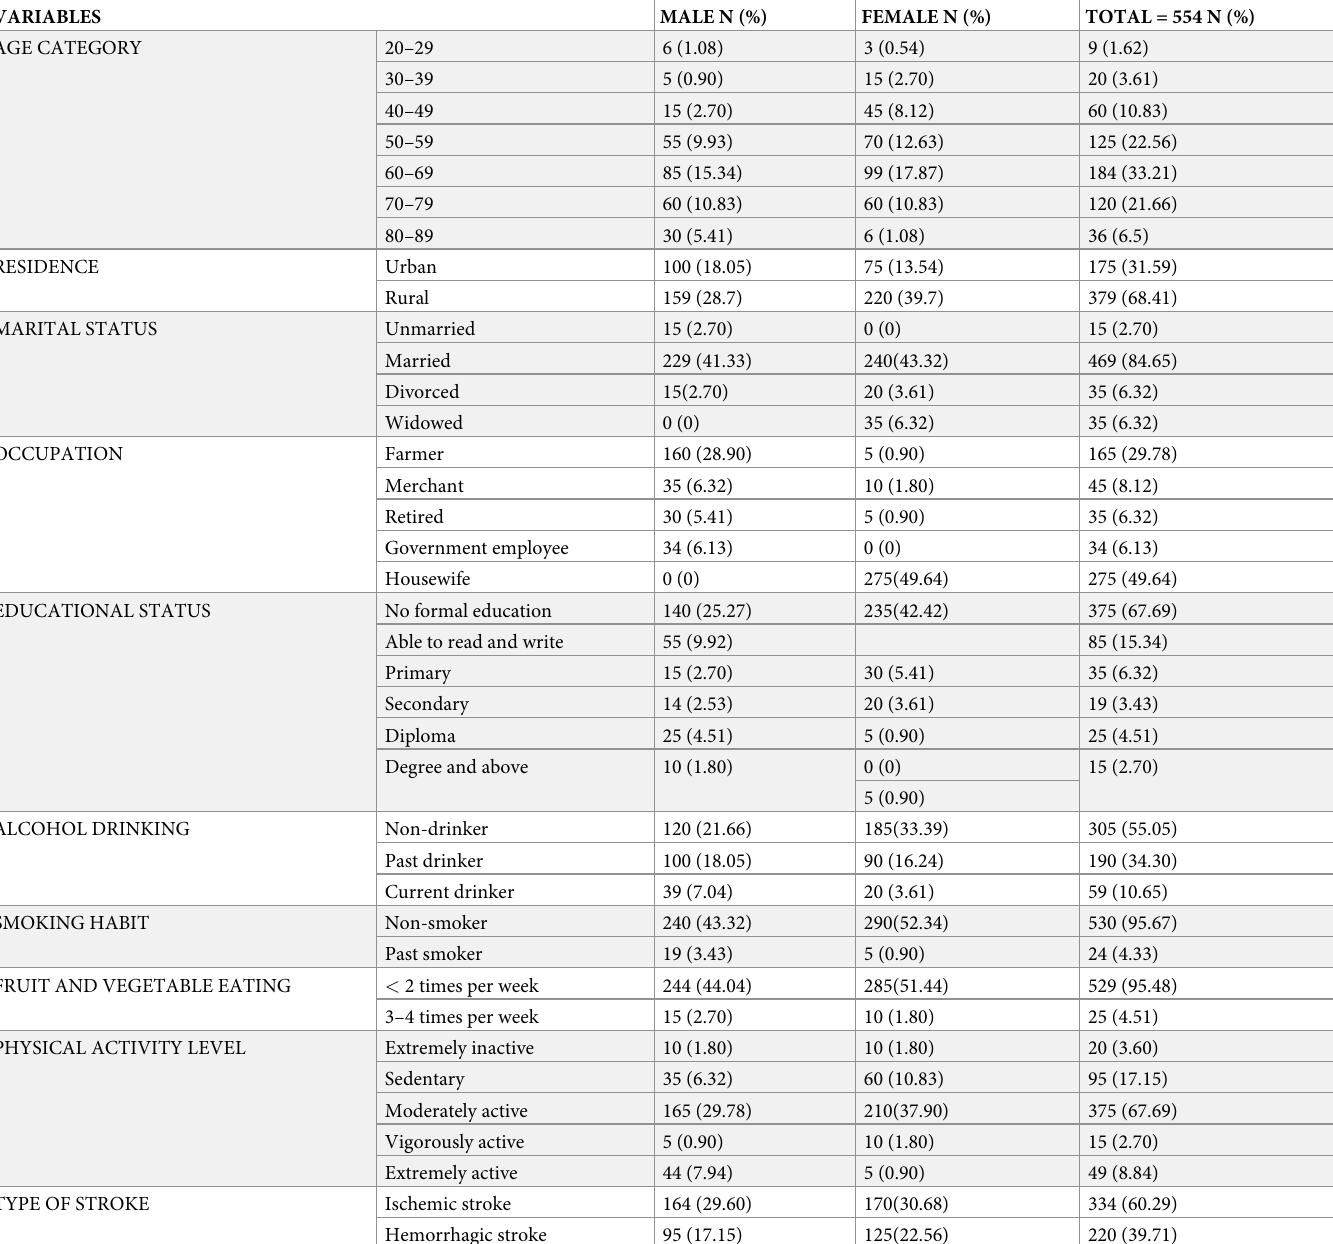
Table 1. Distribution of sociodemographic and behavioral factors in male and female stroke patients in public referral hospitals, Northwest Ethiopia, 2021.